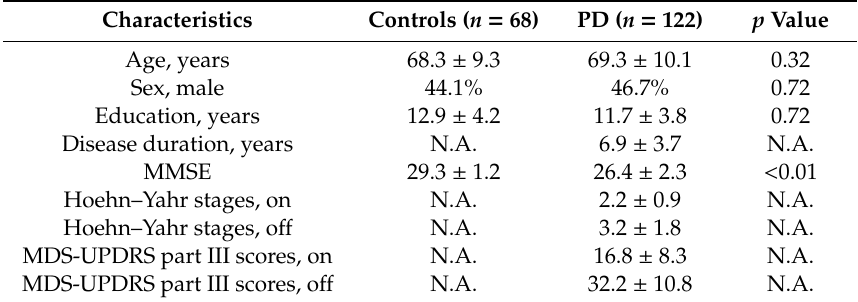
Table 1. Clinical characteristics and plasma biomarker levels of PD patients and controls.